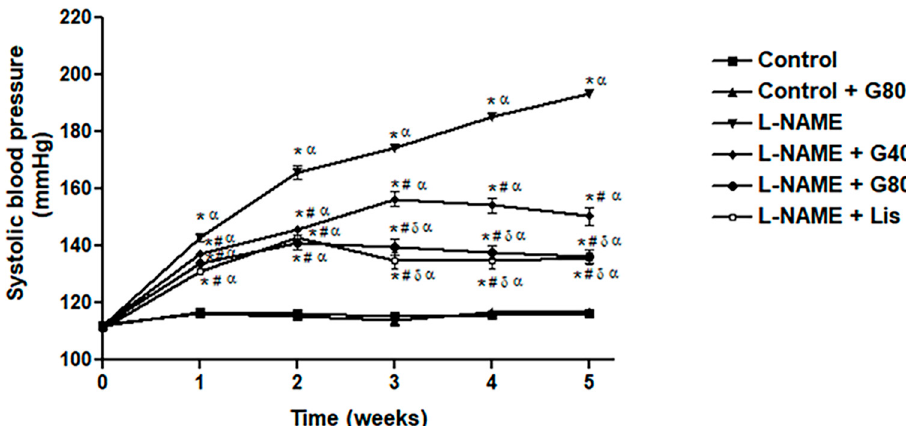
Figure 1. Effect of genistein or lisinopril on weekly systolic blood pressure (SP) in rats treated with N ω -nitro-L-arginine methyl ester hydrochloride (L-NAME). Data are expressed as mean ± SEM. * p < 0.05 vs. control, # p < 0.05 vs. L-NAME, δ p < 0.05 vs. G40, and α p < 0.05 vs. control + G80 ( n = 8/group). Control, normotensive rats; control + G80, normotensive rats treated with genistein 80 mg/kg; L-NAME, N ω -nitro-L-arginine methyl ester hydrochloride; L-NAME + G40, L-NAME hypertensive rats treated with genistein 40 mg/kg; L-NAME + G80, L-NAME hypertensive rats treated with genistein 80 mg/kg; and L-NAME + Lis, L-NAME hypertensive rats treated with lisinopril 5